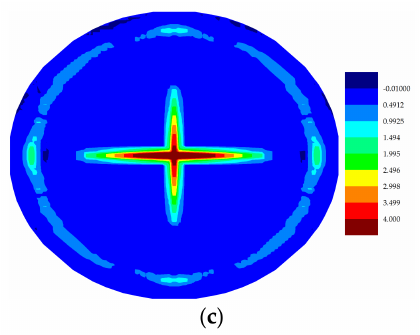
Figure 22. ( a ) Distribution of temperature change (K) of middle ply at 0.28453 × 10 − 3 s; ( b ) Distribution of temperature change (K) of middle ply at 0.3461 × 10 − 3 s; ( c ) Maximum stretch distribution of middle ply at 0.3461 × 10 − 3 s.